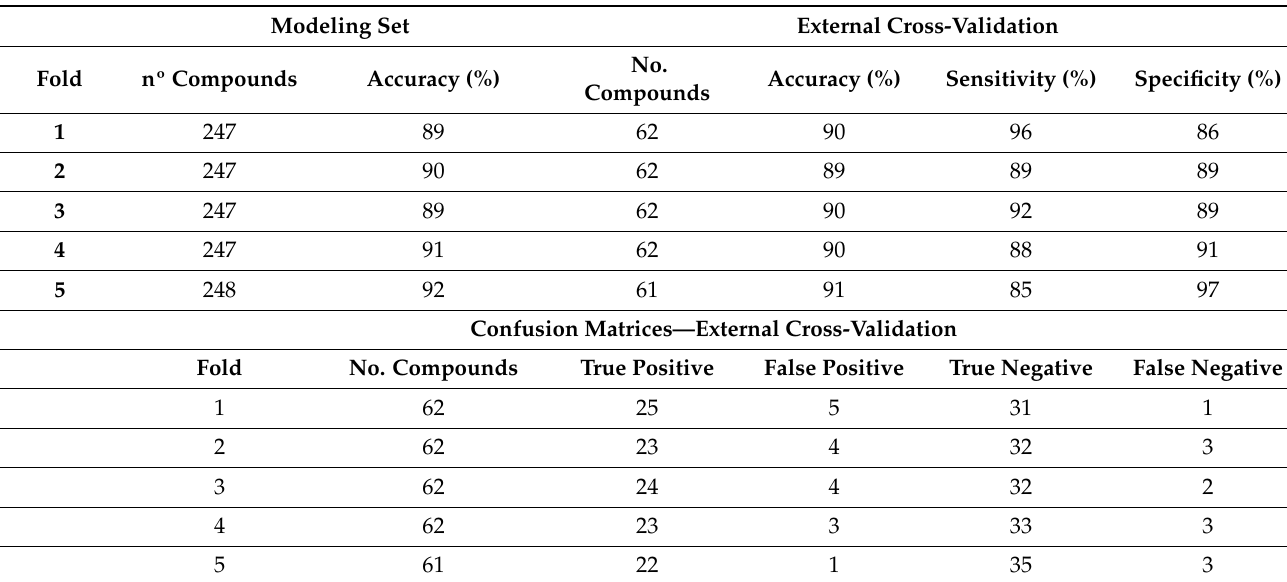
Table 1. Statistical performances and confusion matrices for the RF model.